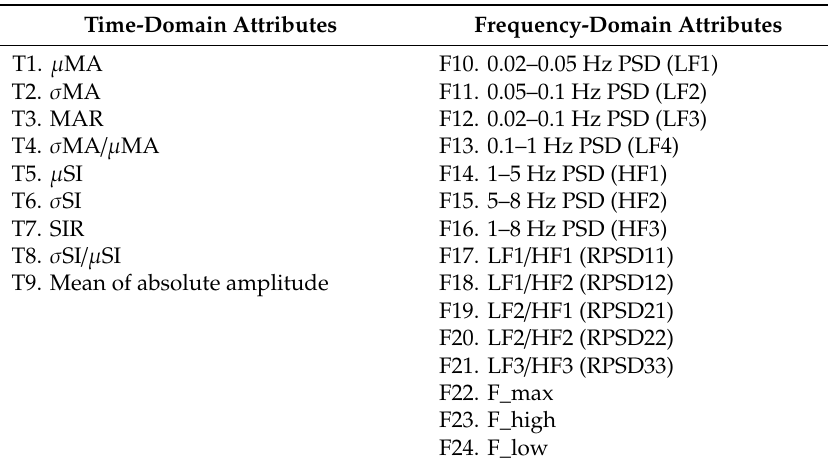
Table 1. Twenty-four attributes used to create the